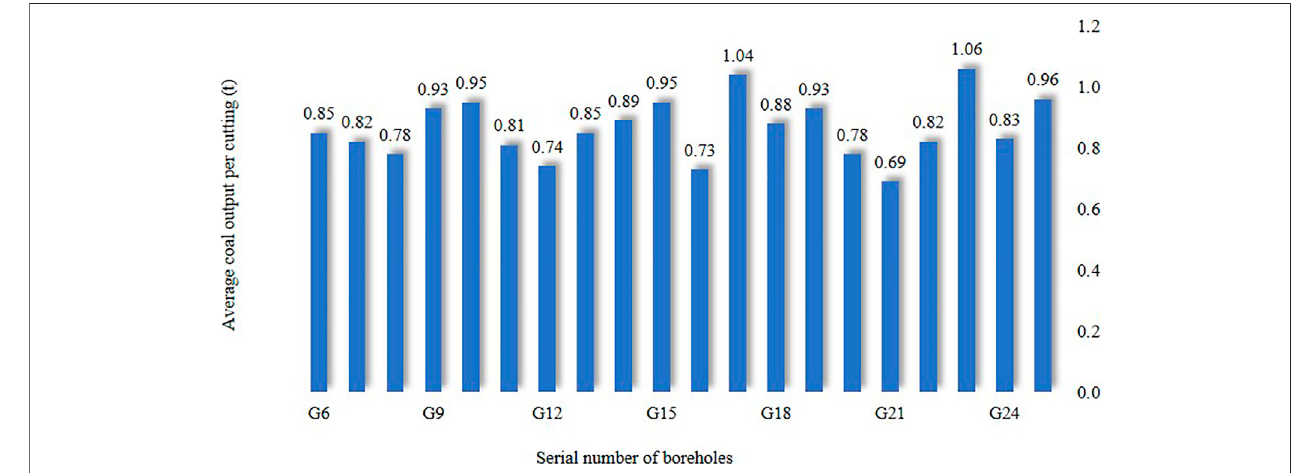
FIGURE 9 | Coal output from boreholes for hydraulic cutting.